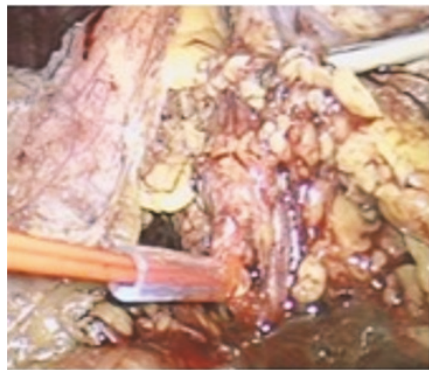
Figure 2: Intraoperative photo from the transperitoneal laparo- scopic left PN demonstrating the occluded left renal artery using Rummel Tourniquet